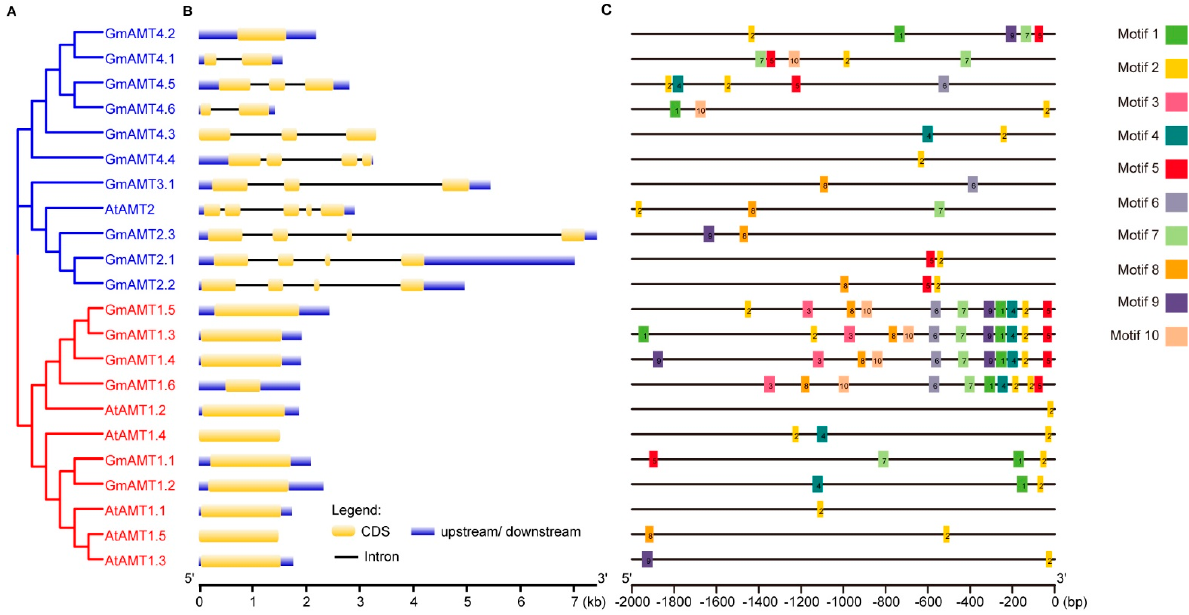
Figure 4. Gene structures and promoter-conserved motif analysis of the AMT family in soybean and Arabidopsis . ( A ) Phylogenetic tree analysis of AMTs in Arabidopsis and soybean. Maximum-likelihood trees were constructed by MEGA-X software with 1000-fold bootstrap resampling. The red and blue branches represent the AMT1 and AMT2 subfamilies, respectively. ( B ) Gene structure analysis of AMT genes by the GSDS 2.0 online website. The yellow boxes represent CDS regions, blue boxes represent UTR regions, and black lines represent intron regions. ( C ) The conserved motifs of AMT promoters in soybean and Arabidopsis were analyzed by the MEME website. Di ff erent colors represent di ff erent conserved motifs. The 2 kb promoters of AMT genes in soybean and Arabidopsis were obtained from the Phytozome database.